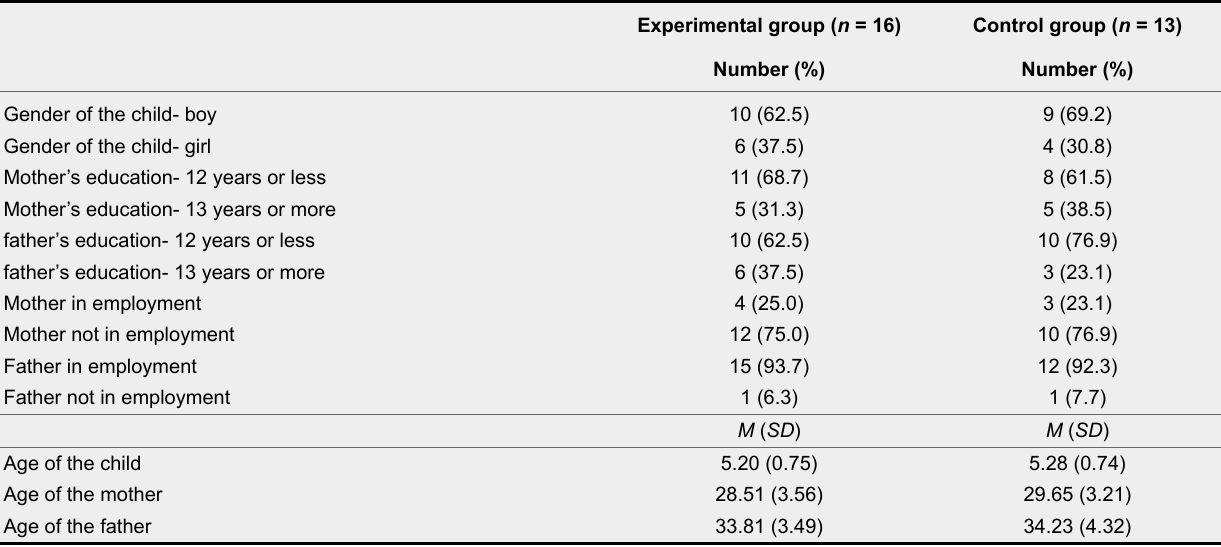
Demographic Characteristics of